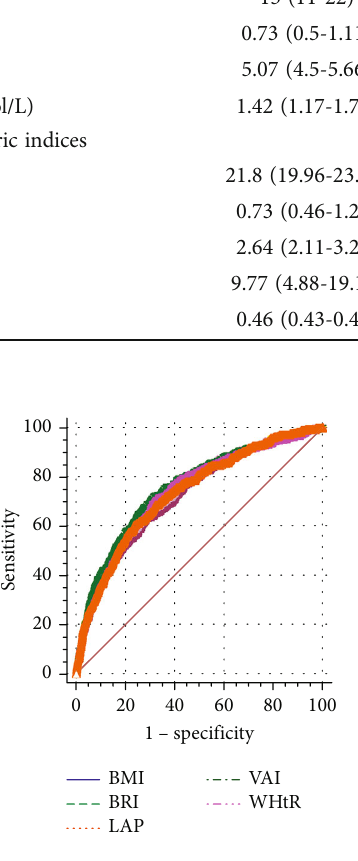
Figure 1: ROC curves of fi ve obesity evaluation markers for predicting the onset of type 2